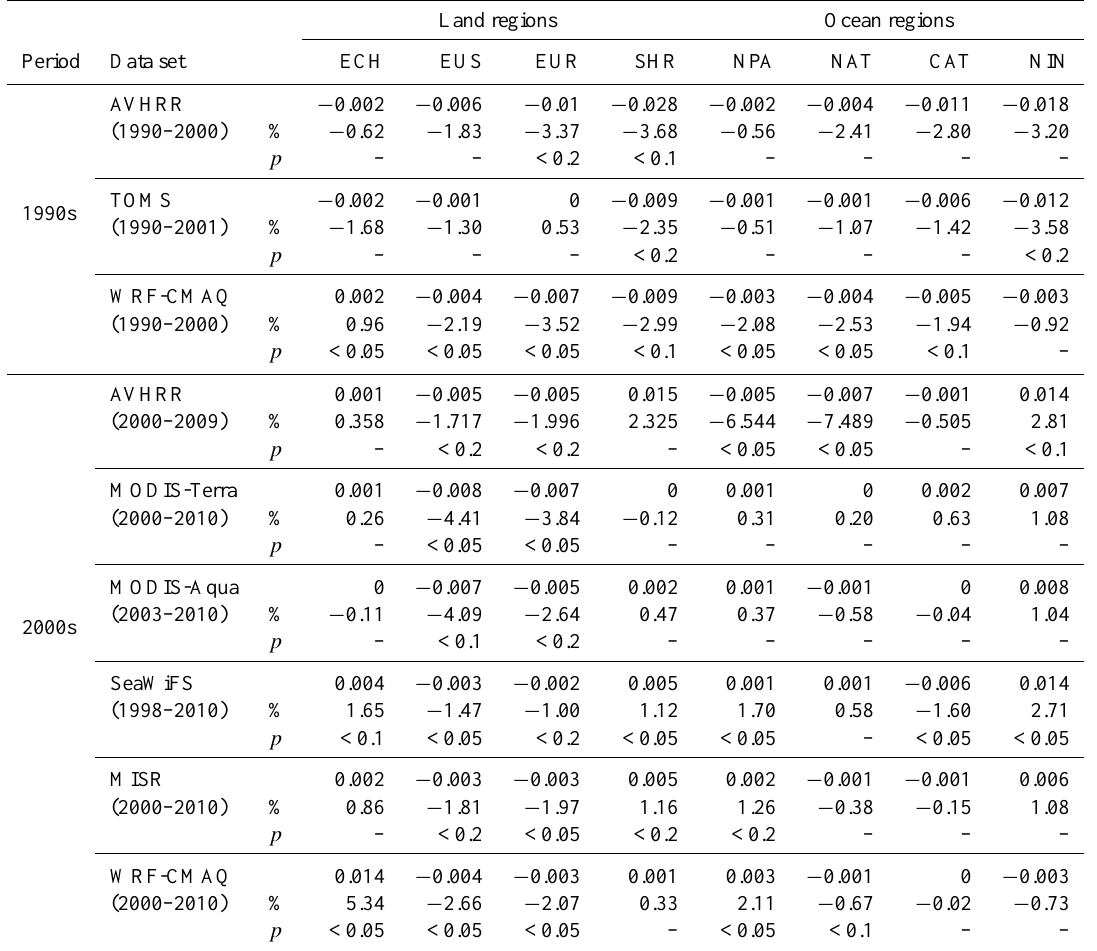
Table 2. Trends in regional AOD from satellite retrievals and the WRF-CMAQ model. Land regions Ocean